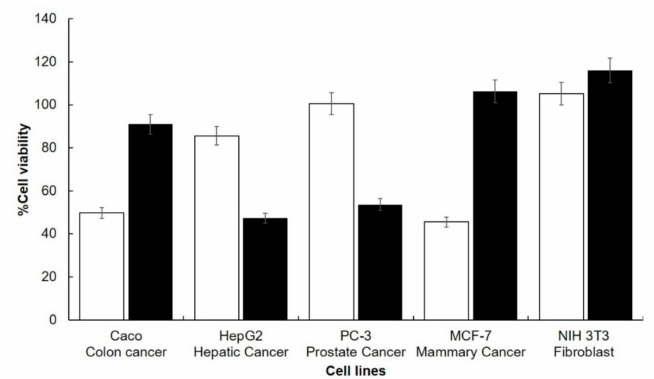
Figure 3. E ff ect of clarified juices extracts of chico fruit (white) and jiotilla (black) at 2% on the cell viability. The error bars are standard